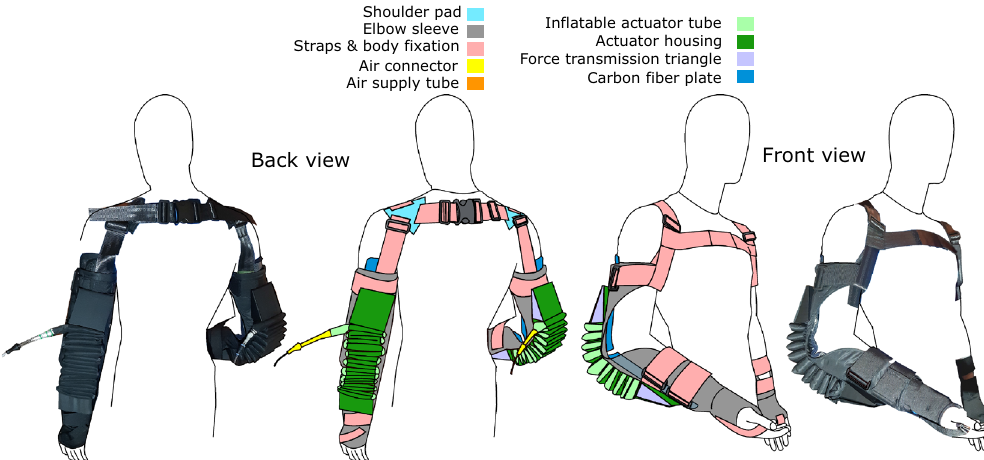
Figure 1. Pneumatic soft elbow exoskeleton (Carry) front and back view.